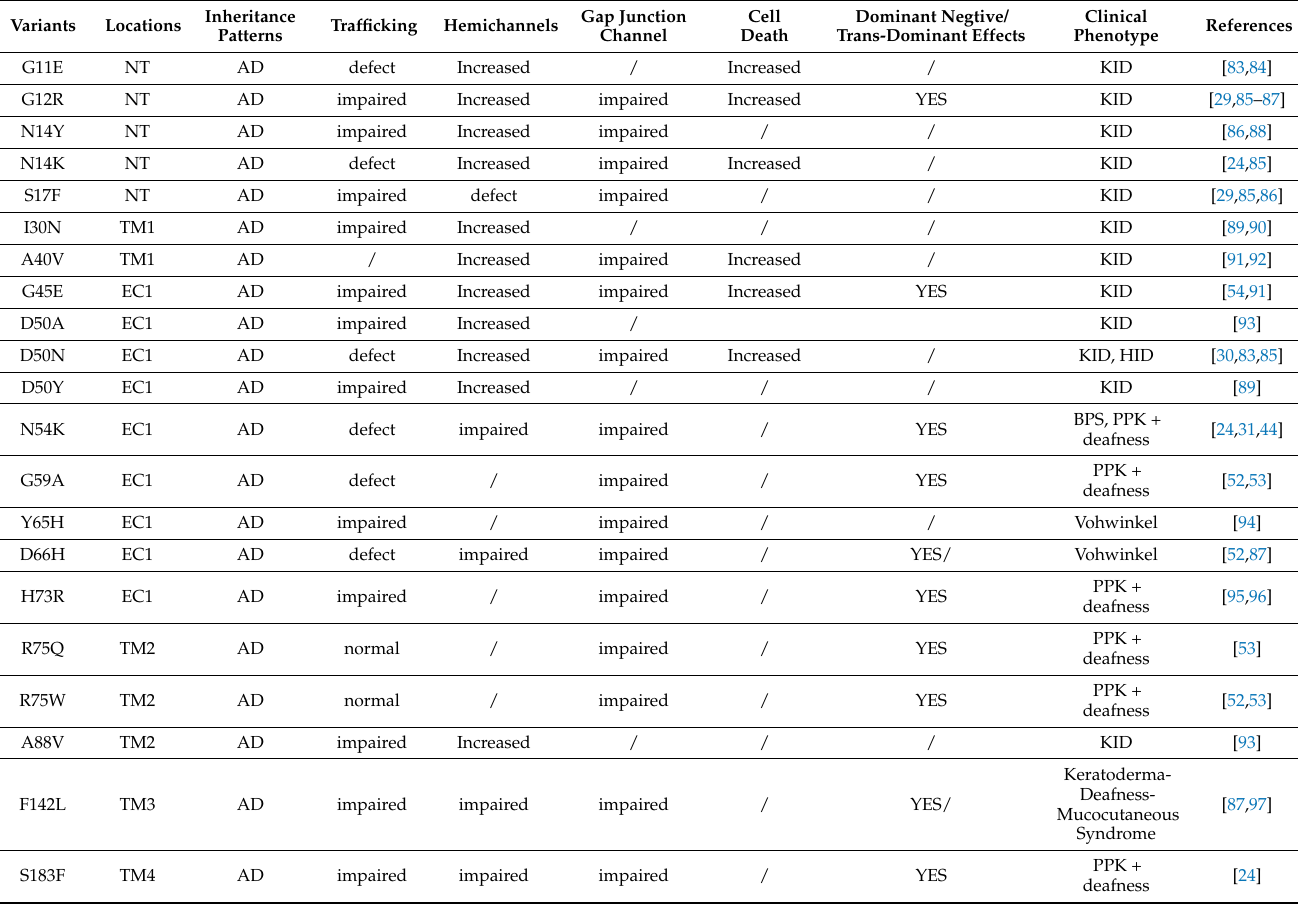
Table 2. Molecular mechanisms and phenotypes of syndromic hearing loss